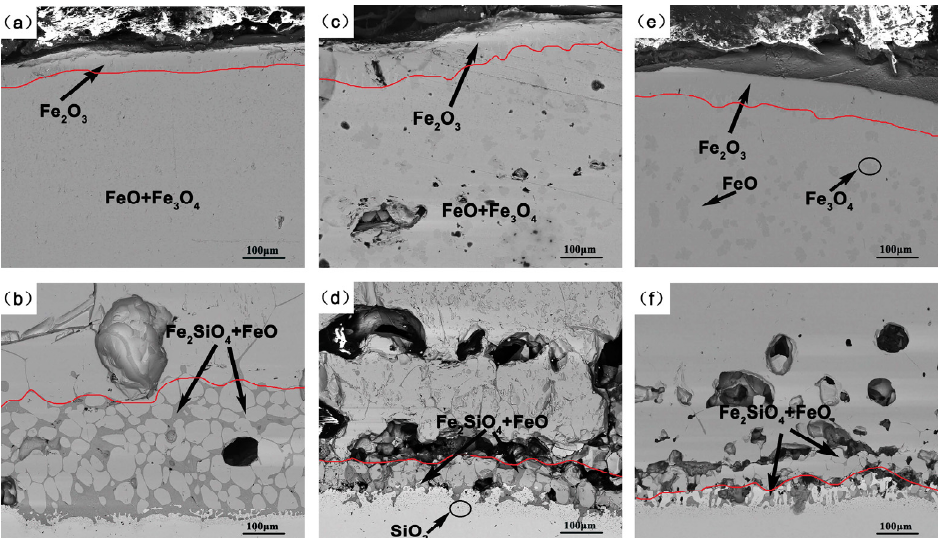
Figure 2. The morphology micrographs of oxide scale on cross-sections of three steels. ( a ) The upper and middle layers and ( b ) the inner layer of Steel 1 (Si 1.21%); ( c ) the upper and middle layers and ( d ) the inner layer of Steel 2 (Si 0.25%); ( e ) the upper and middle layers and ( f ) the inner layer of Steel 3 (Si 0.09%).